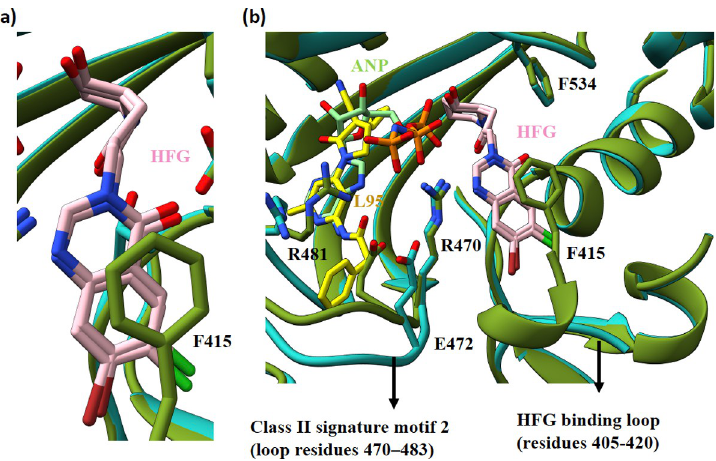
Fig 3. Structural comparison of HFG-ANP and HFG-L95 bound Tg PRSs. (a and b) Superposition of Tg PRS-HFG-L95 (PDB id 7EVU) (cyan) and Tg PRS-HFG-ANP (PDB id 5XIQ) (olive) complexes showing the bound pose of ligand HFG and ligand induced movement of